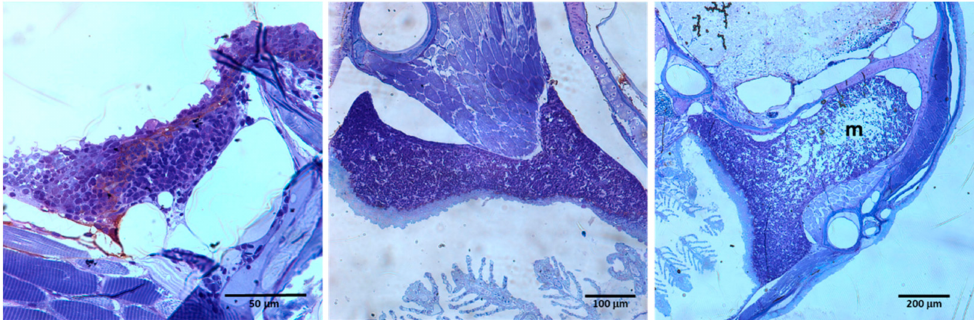
Figure 2. Serial sections of 3-month-old zebrafish thymus. Note that it is only possible to distinguish a central medulla (m) surrounded by a cortex densely occupied by thymocytes when the section shape